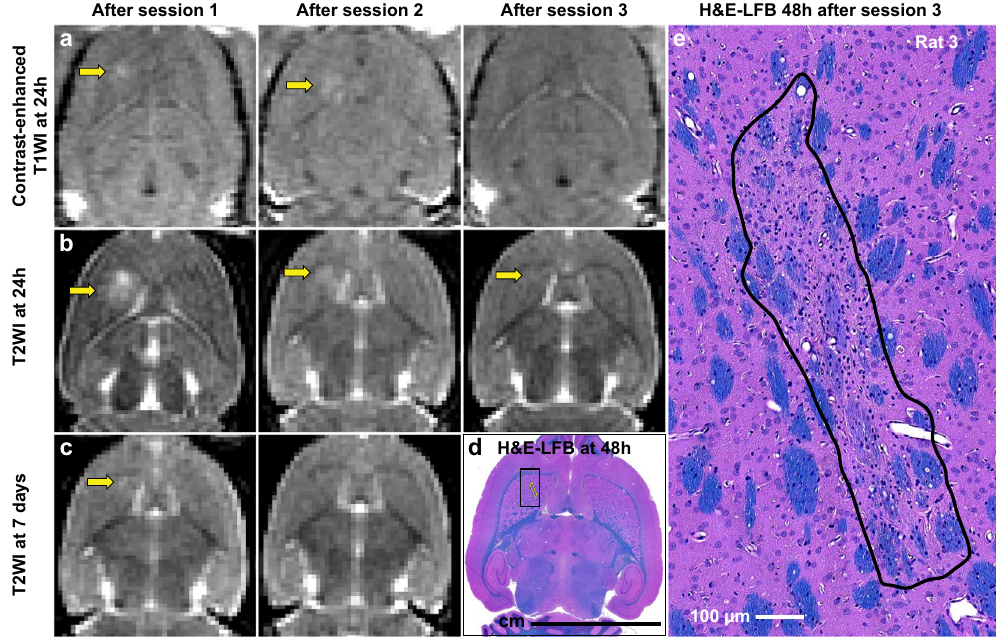
Figure 8. ( a – c ) Axial contrast-enhanced T1-weighted MRI and T2-weighted MRI showing BBB disruption and edema, respectively, at 24 hours and seven days after sonication. In this animal, BBB disruption was evident in the striatum (sonicated volume #1) 24 hours after the first two sessions, but not after the third. Edema was evident after the first session. The location with the most severe edema after the first session persisted and was evident in histology ( d , e ) as a small pale-stained scar (dimensions: 1.2 × 0.27